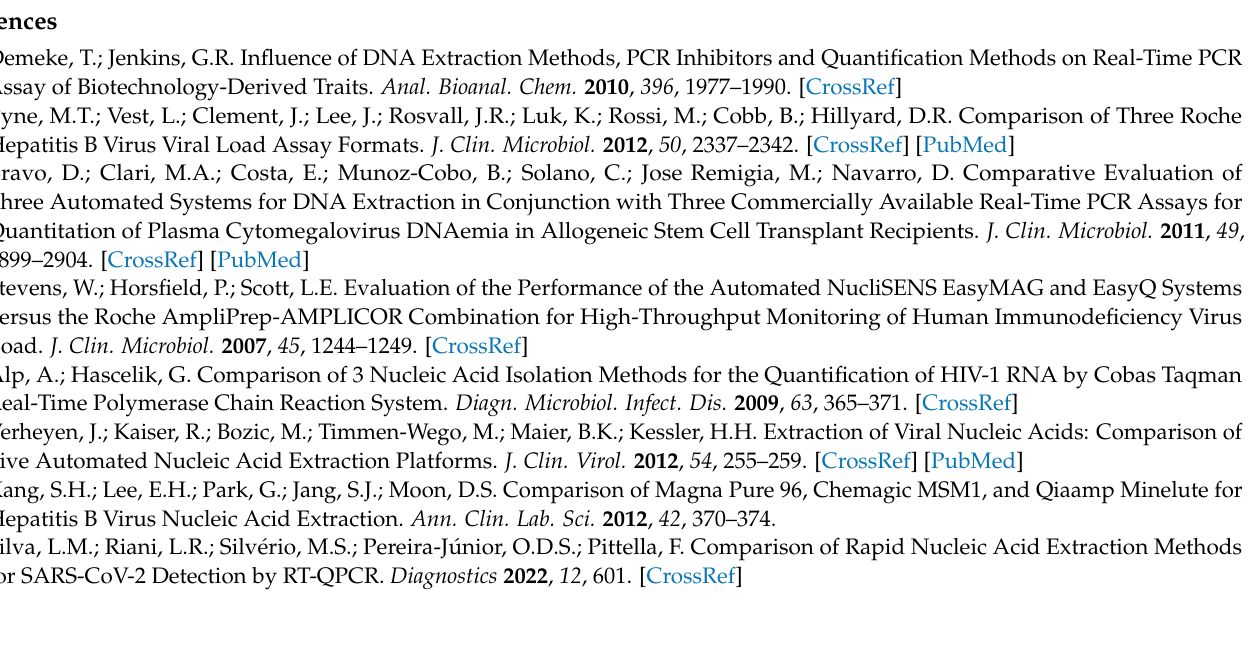
on spectrophotometric measurem; Table S4: Primers and probes used in the dPCR quantification; Table S5: Repeatability with coefficient of variance (CV) for A. baumannii for the three bacterial concentrations; Table S6: Repeatability with coefficient of variance (CV) for K. pneumoniae for the three bacterial concentrations; Table S7: Repeatability with coefficient of variance (CV) for P. aeruginosa for the three bacterial concentrations; Table S8: Intermediate precision with coefficient of variance (CV) for A. baumannii for the three bacterial concentrations; Table S9: Intermediate precision with coefficient of variance (CV) for K. pneumoniae for the three bacterial concentrations; Table S10: Intermediate precision with coefficient of variance (CV) for P. aeruginosa for the three bacterial